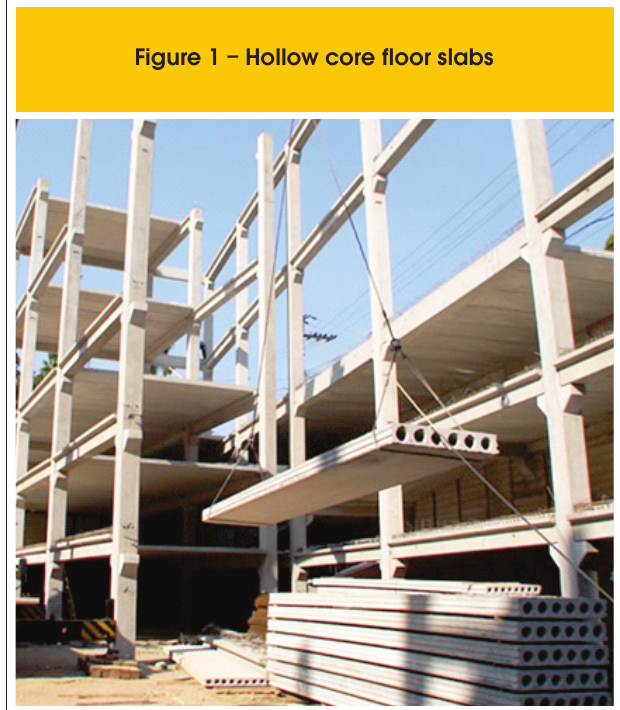
Figure 4 – Continuity set out by placing reinforcement in the